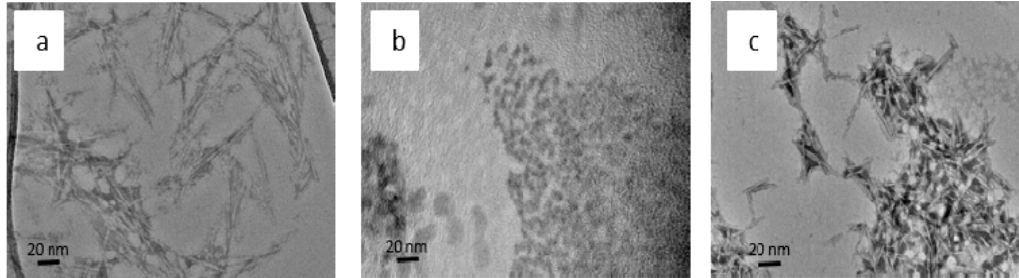
Figure 1. TEM Images of ( a ) CNCs, ( b ) ZnO Nanoparticles, and ( c ) ZnO Coated CNCs.